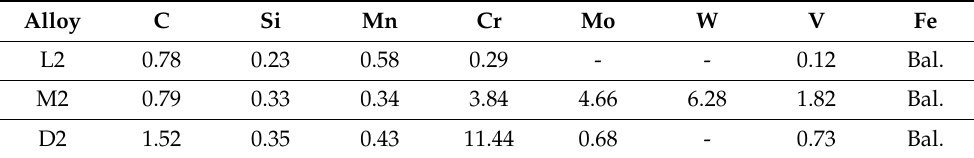
Table 2. Heat treatment of the investigated alloys.